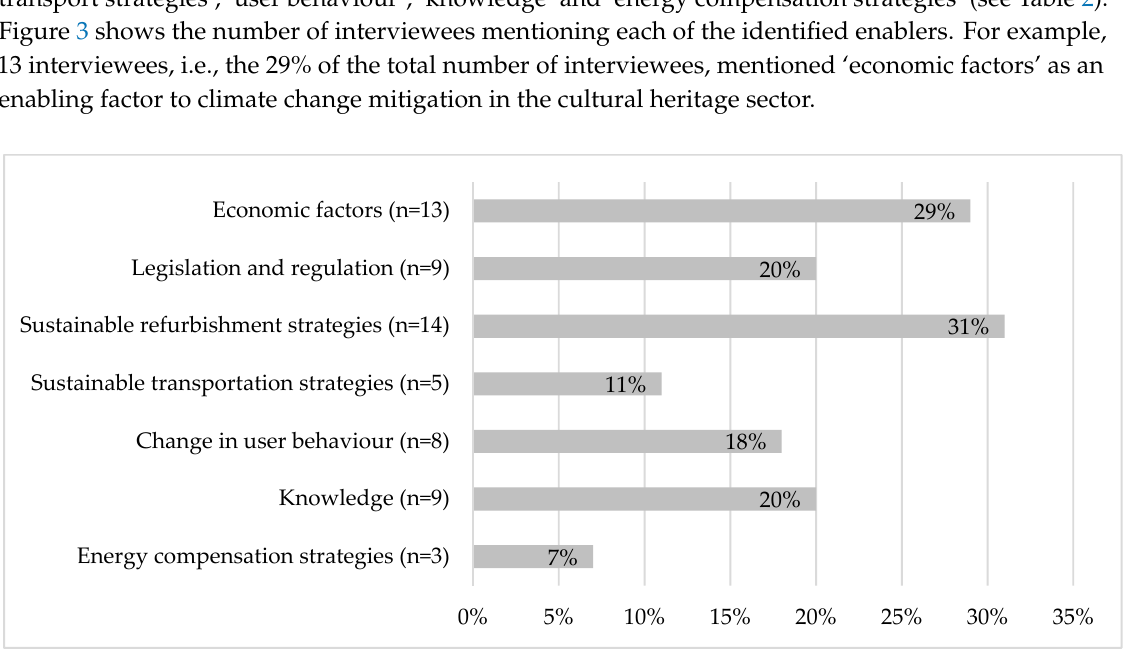
Figure 2. The qualitative methodology used in the current research.